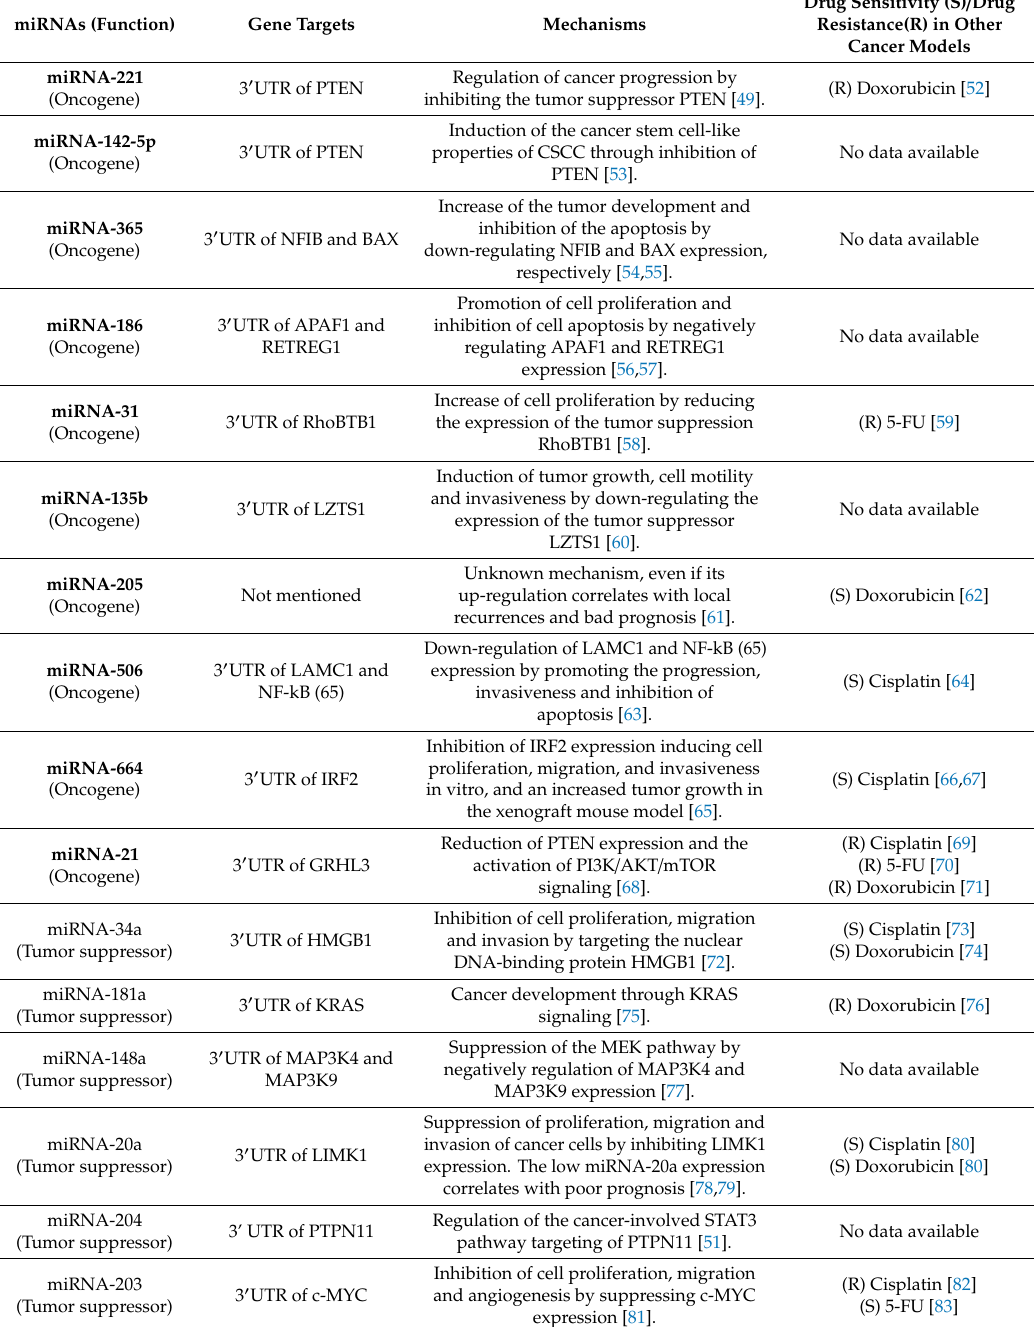
Table 2. Up-regulated (in bold) and down-regulated (normal letters) miRNAs in CSCC. miRNAs (Function) Gene Targets Mechanisms